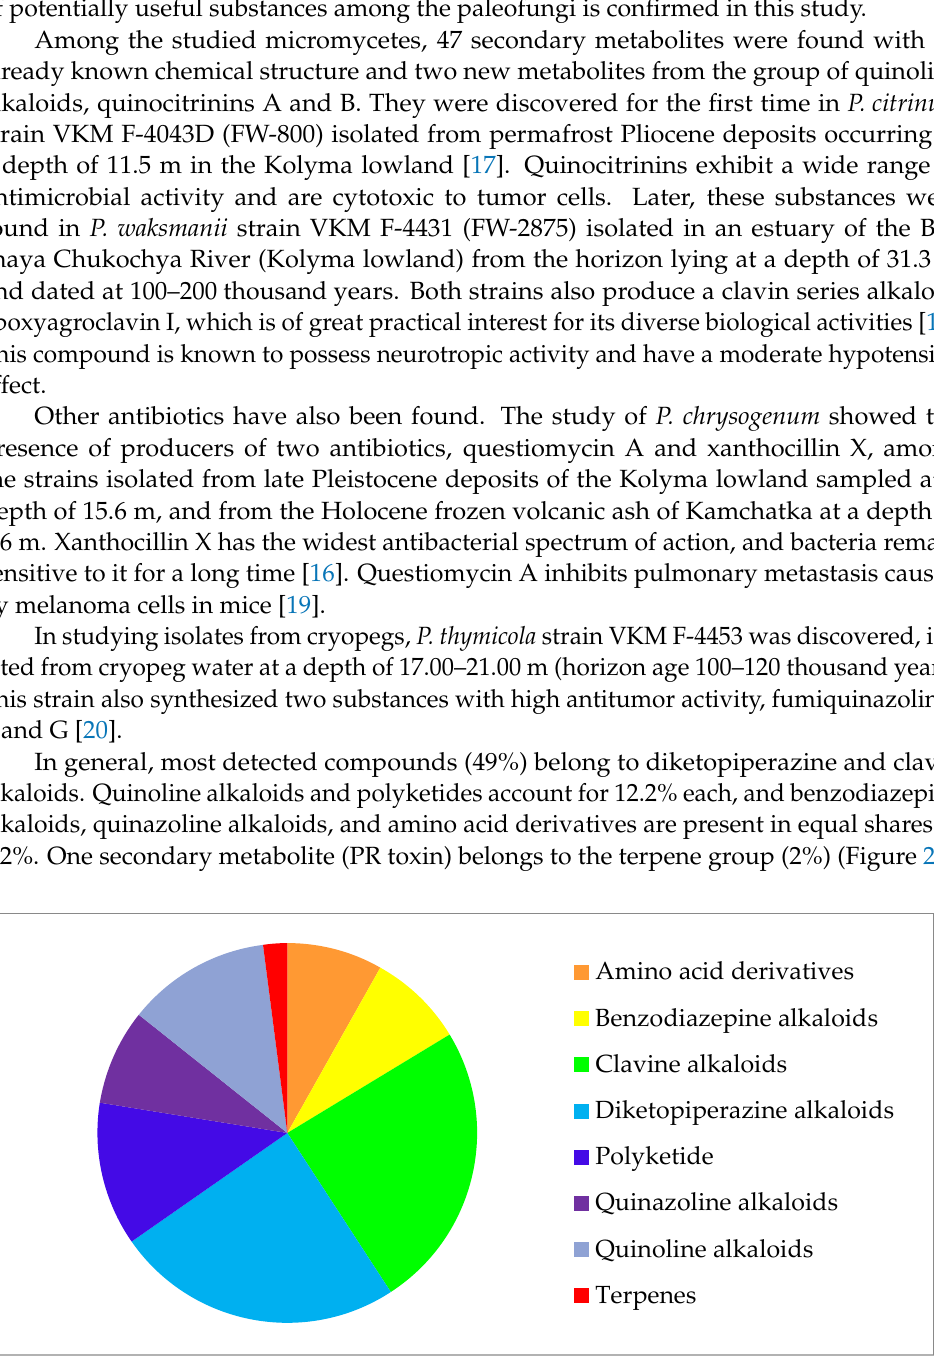
Figure 2. Secondary metabolites of Penicillium strains from collection of paleofungi. The data above confirm that the study of fungi from the circumpolar regions is very promising for biotechnology and